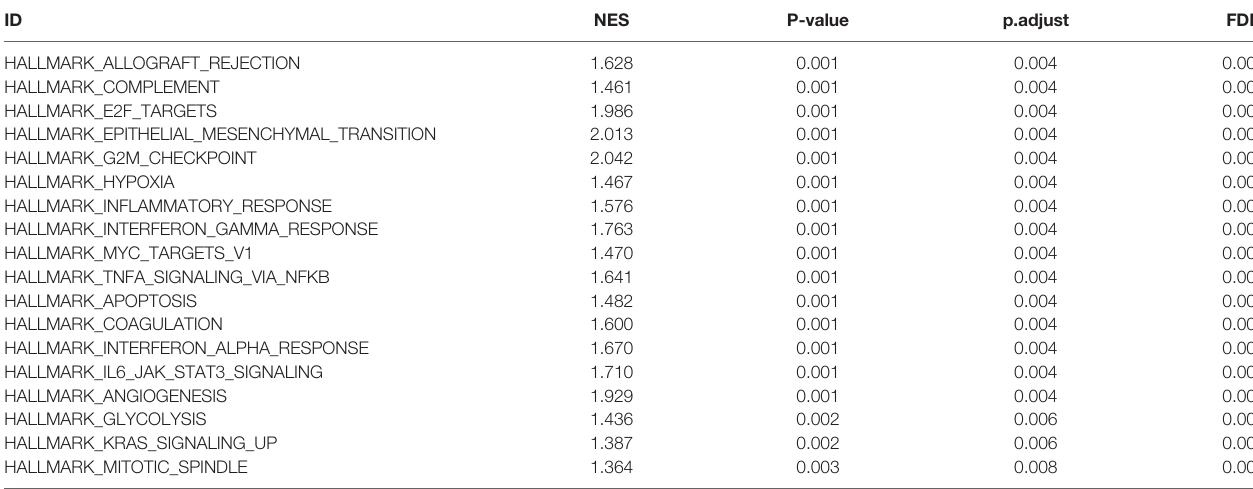
TABLE 3 | Hallmark Pathways enriched in high- and low-risk groups by using GSEA. ID NES P-value p.adjust